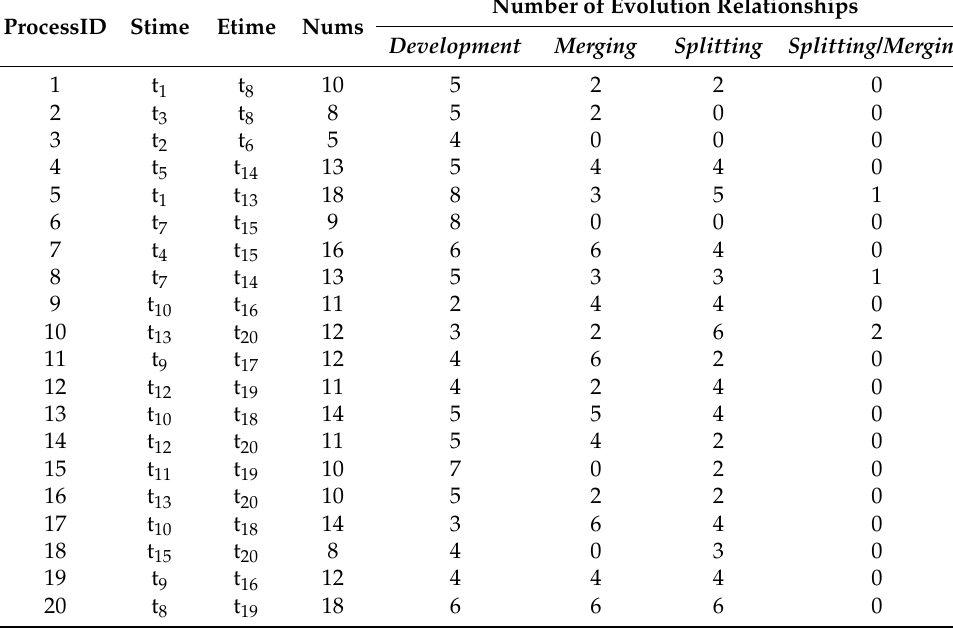
Figure 5. Simulated datasets of process objects and noises.